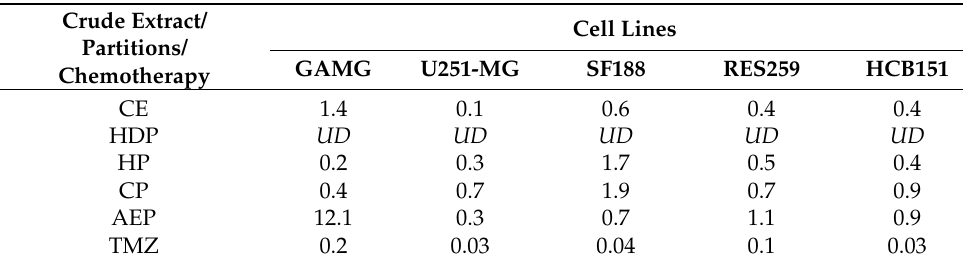
Table 4. Selectivity index for crude extracts and partitions from Miconia chamissois and chemotherapy, temozolomide.